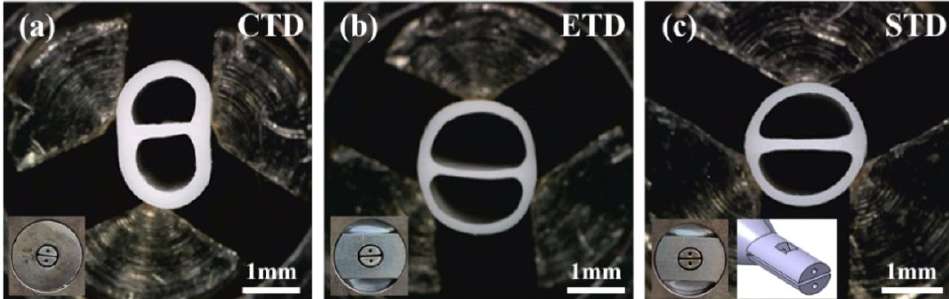
Figure 7. Comparison of numerical analysis and experimental result: ( a − c ) 2D tomographic images; ( a` − c` ) photograph of actual multi lumen tubes; and ( a`` − c`` ) wire frame data of numerical analysis result.